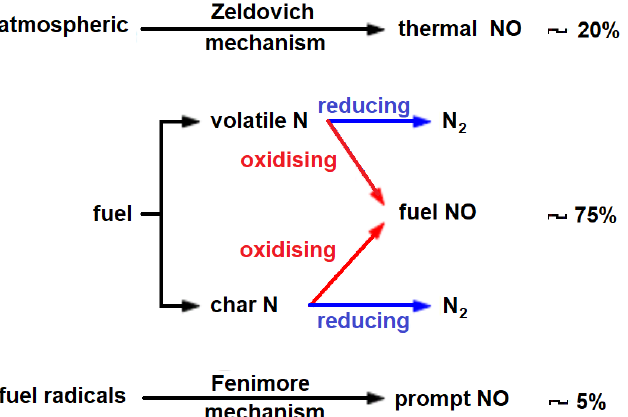
Figure 2. Scheme of nitrogen interaction in the generation of flame burning